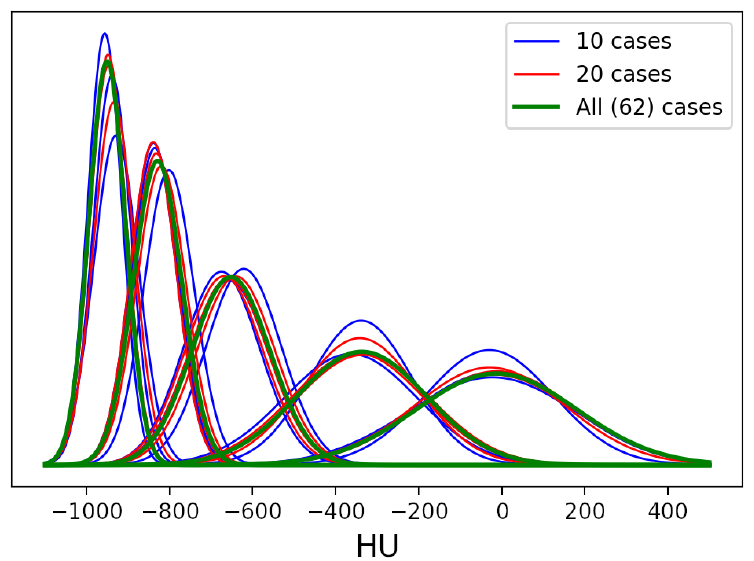
Figure 4. Estimated Gaussians for each fold of the robustness test. Multiple lines of the same color show the results obtained from different groups of the same fold size.